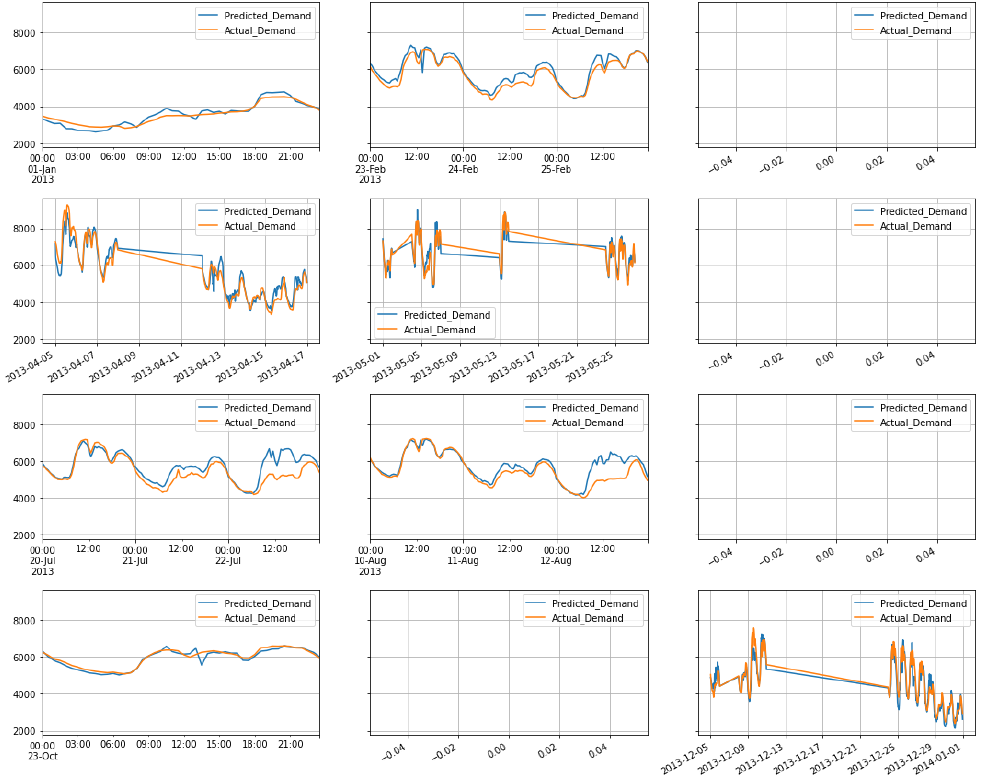
Figure A3. Forecasting performance of the VR model (Group 3).